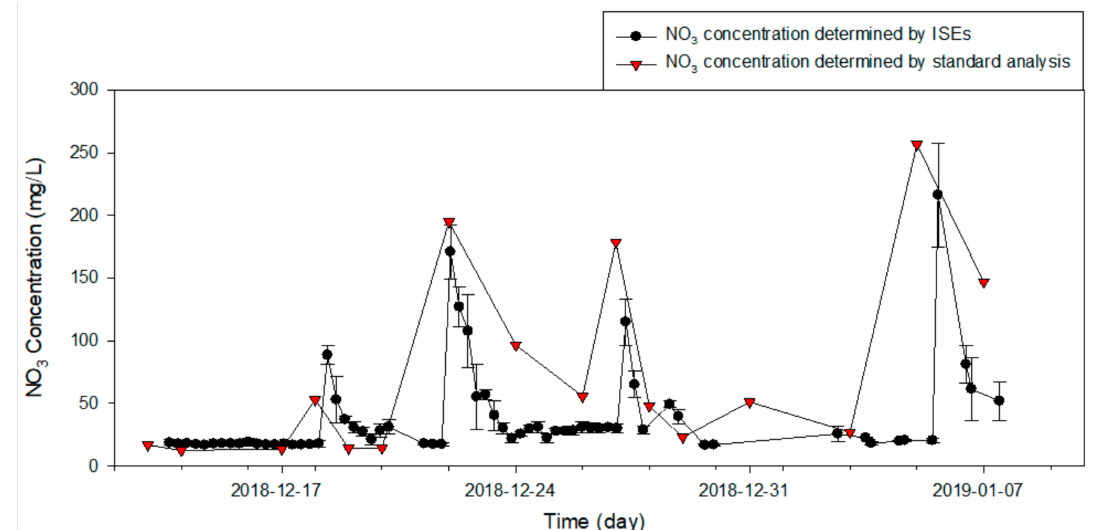
Figure 10. Comparison of nitrate concentrations predicted by ISE and standard analyzer.